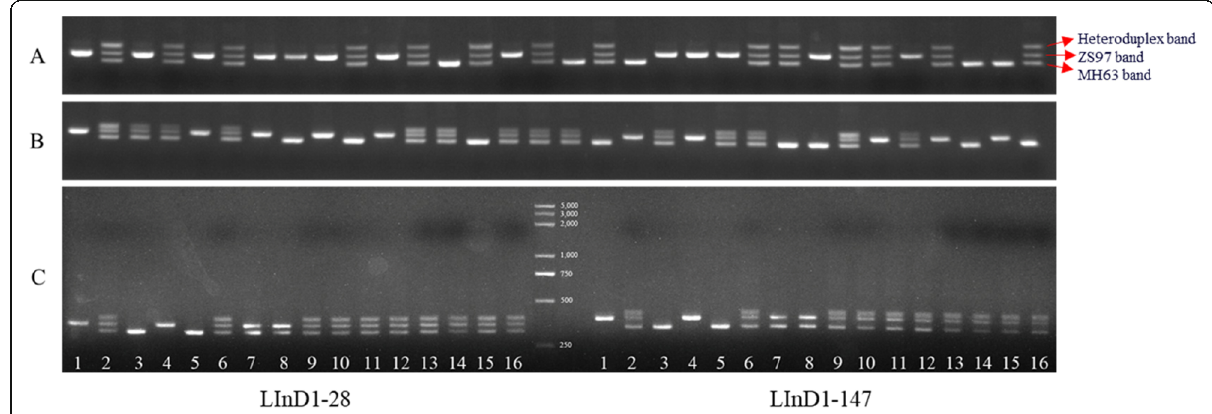
Fig. 6 The genotypes of the F 2 plants at the two LInDel marker loci and the verification of the heteroduplexes. a and b the genotypes of the F 2 plants at the InDel marker loci of LInD1 – 28 and LInD1 – 147, three different bands were explained with red arrows. c the verification of the heteroduplexes. Lanes 1 – 10 are the nondenatured PCR products as follows: lanes 1 – 3, three F 2 plants; lanes 4 – 6, ZS97, MH63 and their F 1 cross SY63; lane 7, the mixed PCR products of the two types of homozygous F 2 plants; lane 8, the mixed PCR products of ZS97 and MH63; lane 9, the PCR products amplified from the mixed DNA of two types of homozygous F 2 plants; lane 10, the PCR products amplified from the mixed DNA of ZS97 and MH63; lanes 11 – 16, the denatured PCR products: lanes 11 – 12, the heterozygous F 2 plant and SY63; lane 13, the mixed PCR products of the two types of homozygous F 2 plants; lane 14, the mixed PCR products of ZS97 and MH63; lane 15, the PCR products amplified from the mixed DNA of the two types of homozygous F 2 plants; and lane 16, the PCR products amplified from the mixed DNA of ZS97 and